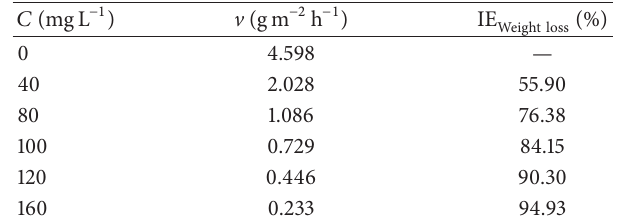
Table 4: The corrosion rate and inhibitor efficiency for carbon steel in 0.5 M HCl in the absence and presence of different concentrations of EAPP at 300 K from weight loss